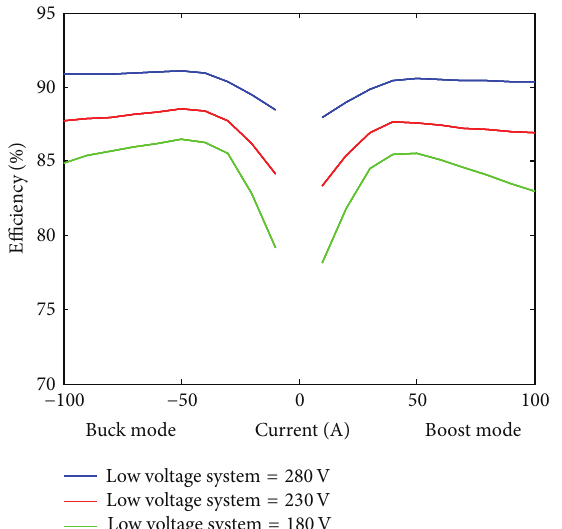
Figure 33: Energy loss of the semiactive topological structure described in Figure 4 for UDDS driving cycle.